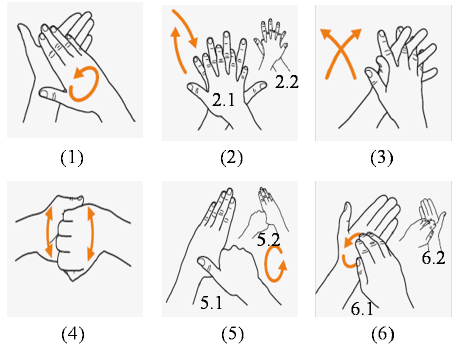
Figure 1: Hand wash guidelines by WHO